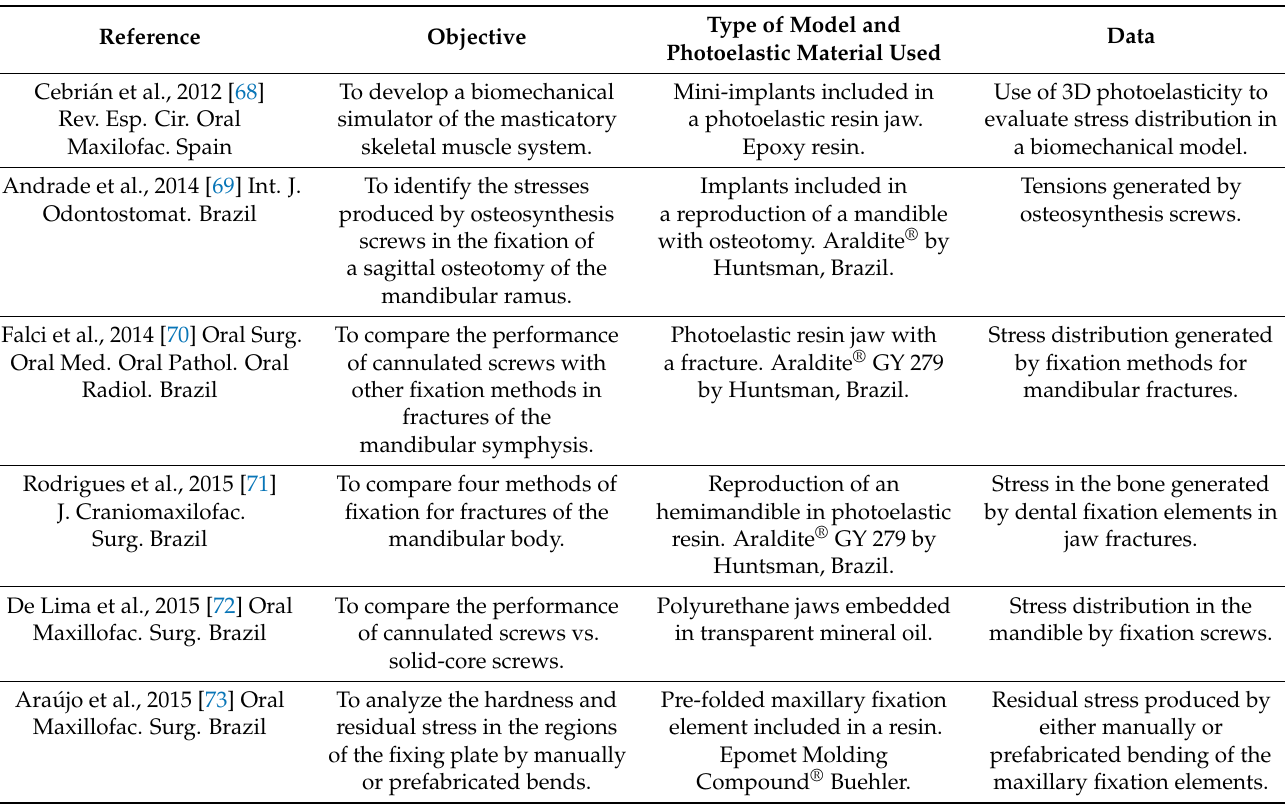
Table 4. Characteristics and findings of studies on implants for surgery in the dental area.